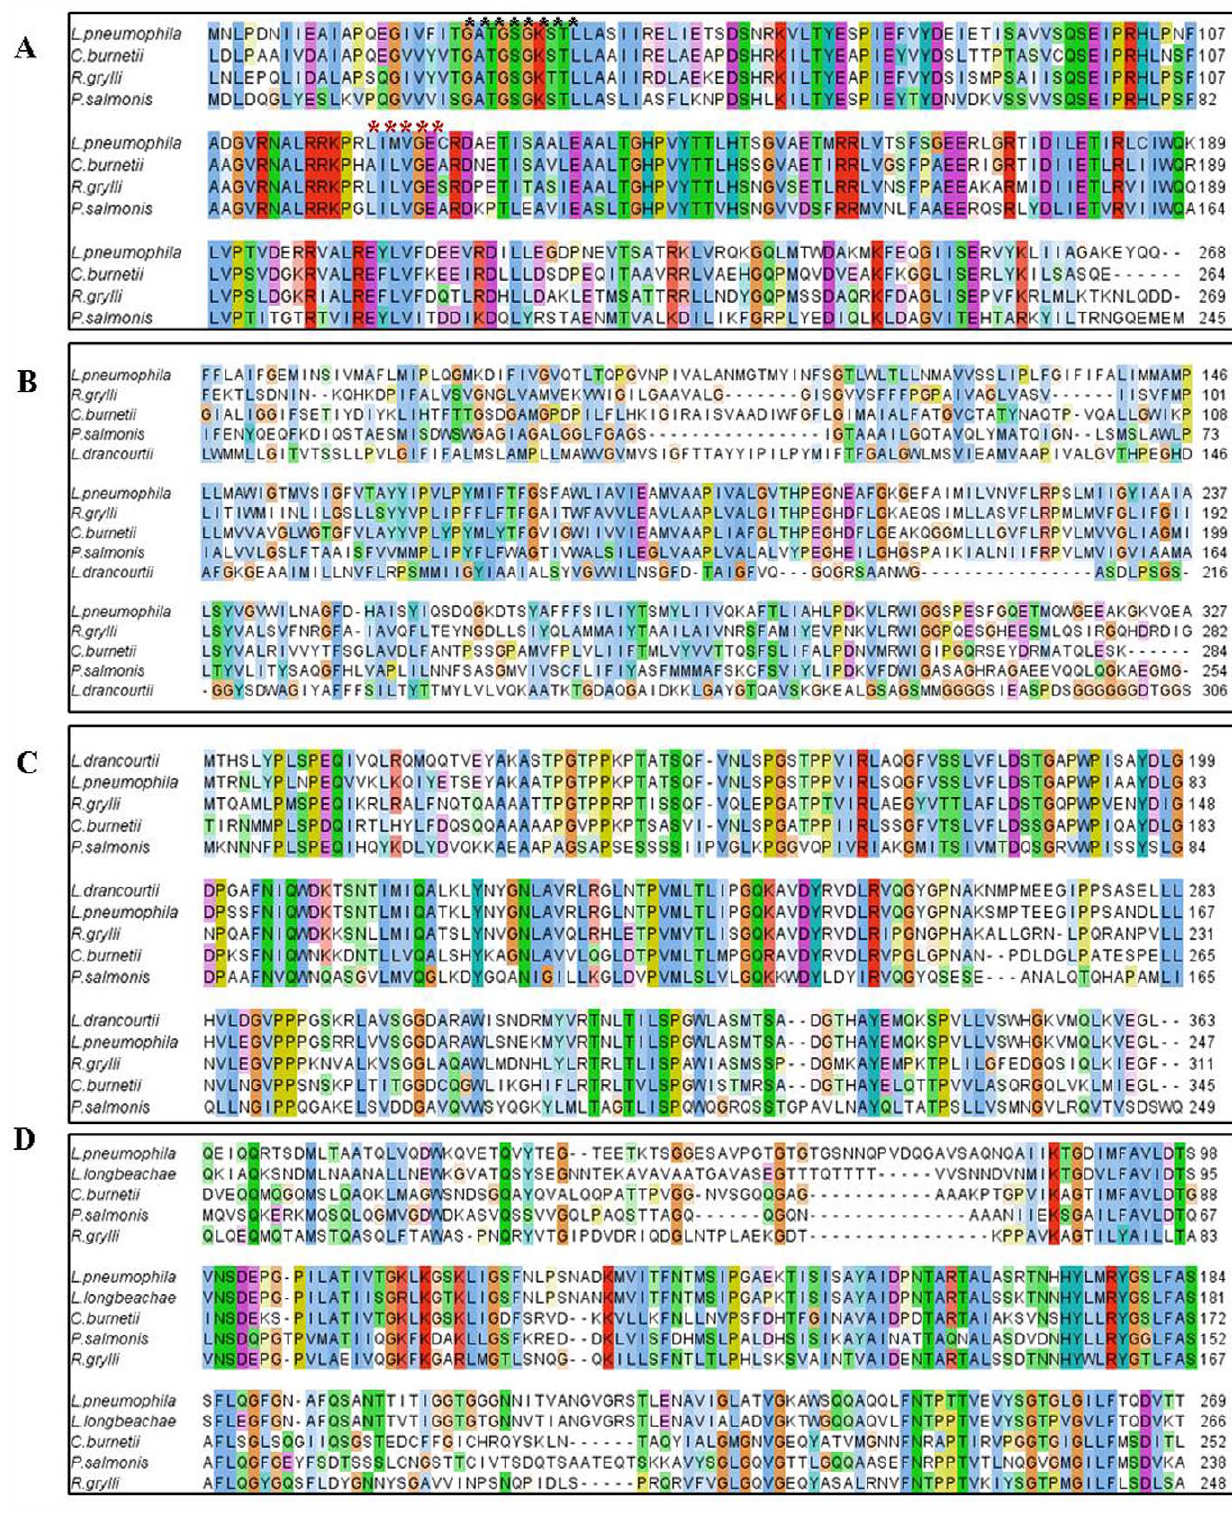
Figure 1. ClustalW alignments among the most conserved regions of P.salmonisdot/icm protein products with their homologues. A: DotB alignment, where the black and red asterisks show the Walker A and B, respectively (ATP binding site); B: DotA alignment; C: IcmK alignment; D: IcmE alignment. All figures were created using Jalview, where the color intensity shows the conservation degree of the aminoacids between the sequences.